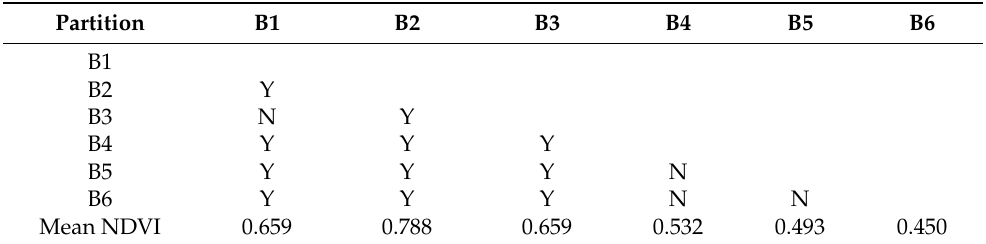
Table 8. Mean vegetation NDVI and statistical significance for every two divisions of land use type (95% confidence level).